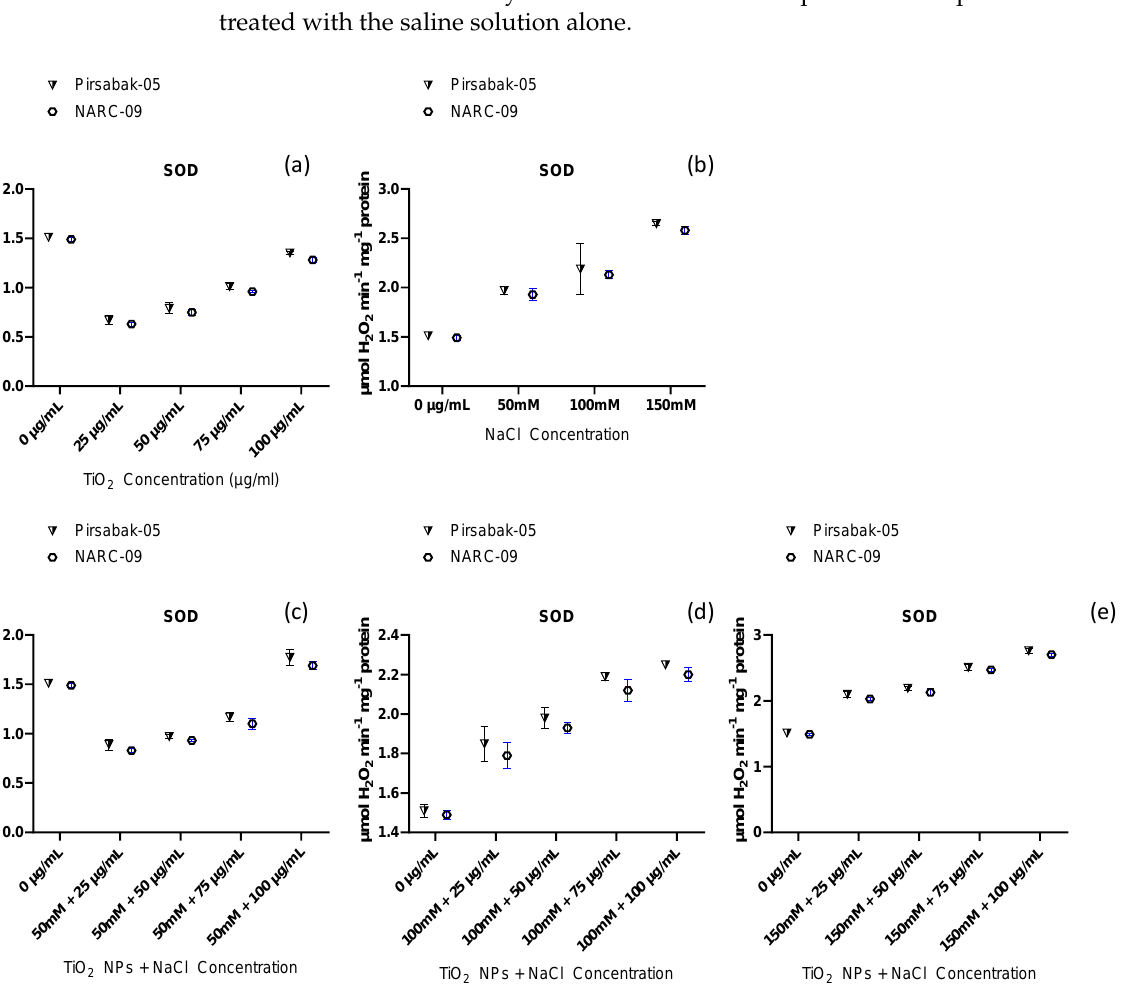
Figure 8. Effects of biogenic TiO 2 NPs on superoxide dismutase (SOD) activity on wheat varieties under salinity stress conditions; ( a ) Effect of different concentrations of biogenic TiO 2 NPs on wheat varieties, ( b ) Effect of different concentrations of NaCl on wheat varieties, ( c – e ) Effect of different concentrations of TiO 2 NPs under varied concentrations (i.e., 50 mM, 100 mM, and 150 mM of NaCl). The data are represented in the form of means, while p was kept at p ≤ 0.05.